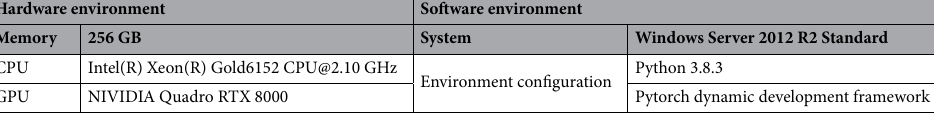
Table 3. Hardware and software parameters of